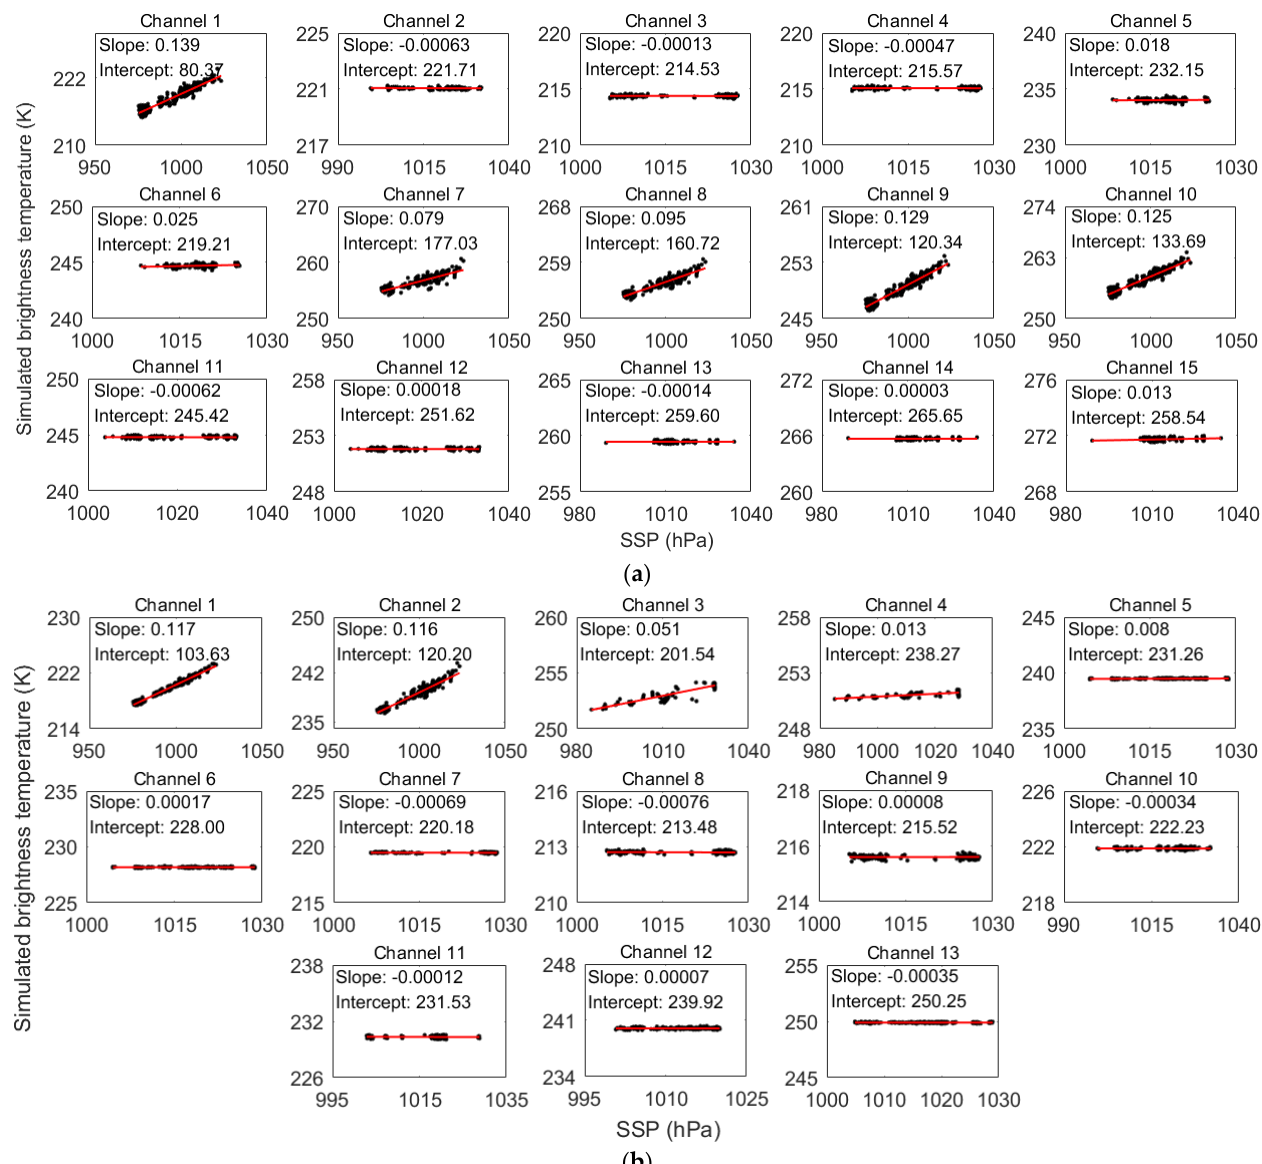
Figure 5. The results of the sensitivity test of MWHTS and MWTS-II to SSP: ( a ) MWHTS; ( b ) MWTS-II.